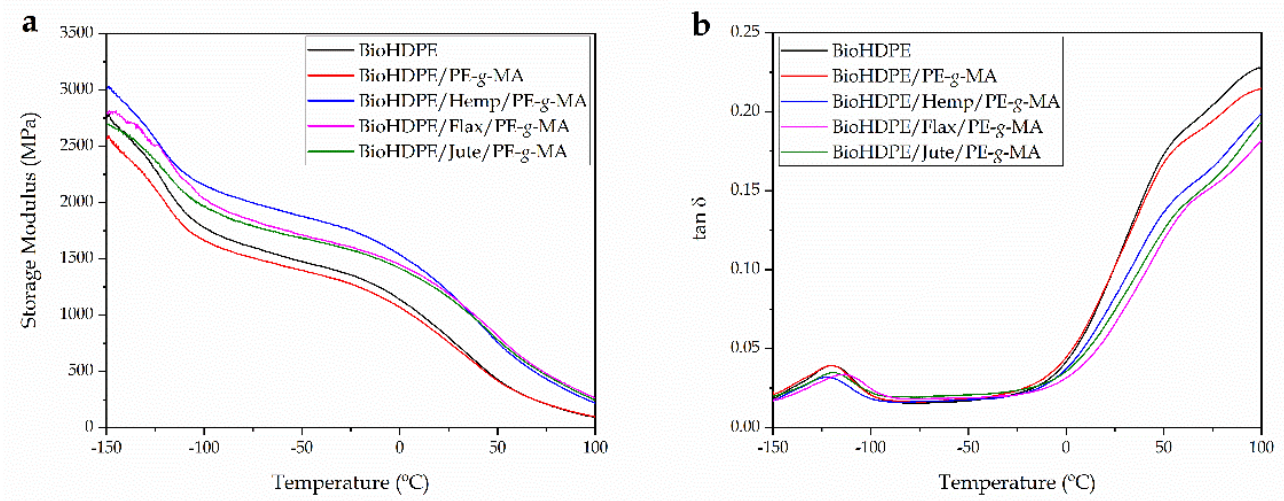
Figure 7. Dynamic mechanical thermal behavior (DMTA) of Bio-HDPE with different natural fibers as a function of temperature, ( a ) storage modulus (E’) and ( b ) dynamic damping factor ( tan δ ).